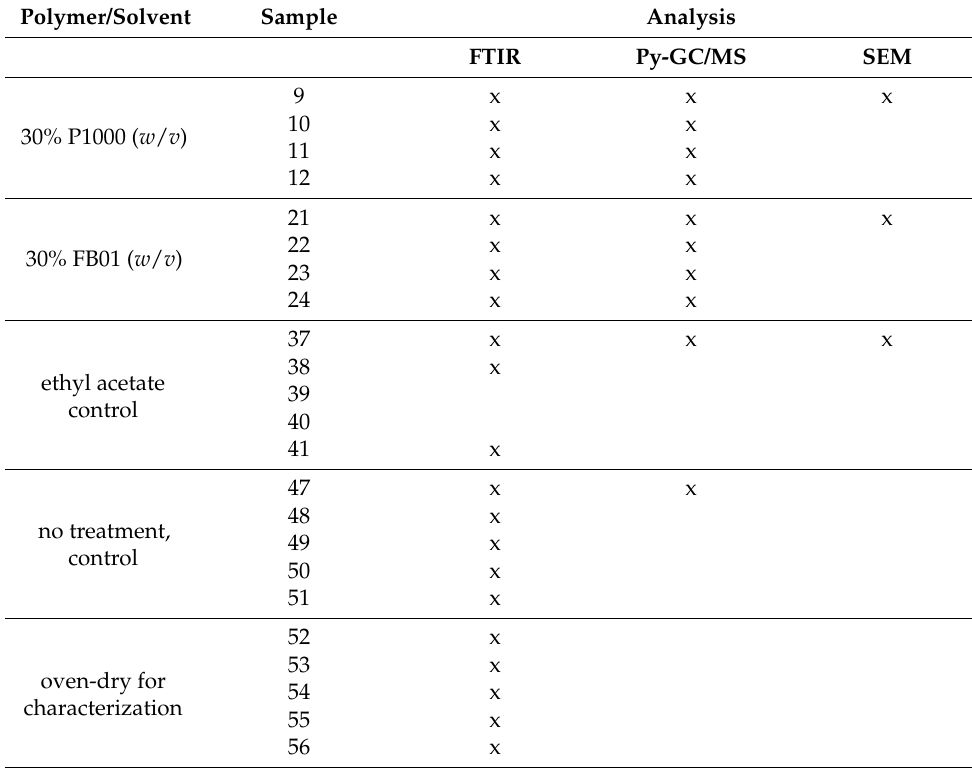
Table 1. Specimens in each polymer, solvent or control group. Analysis methods are also indicated for each